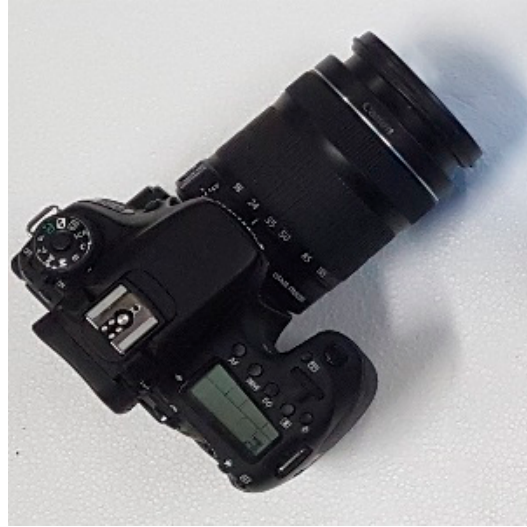
Figure 1. DSLR Canon EOS-70D camera.